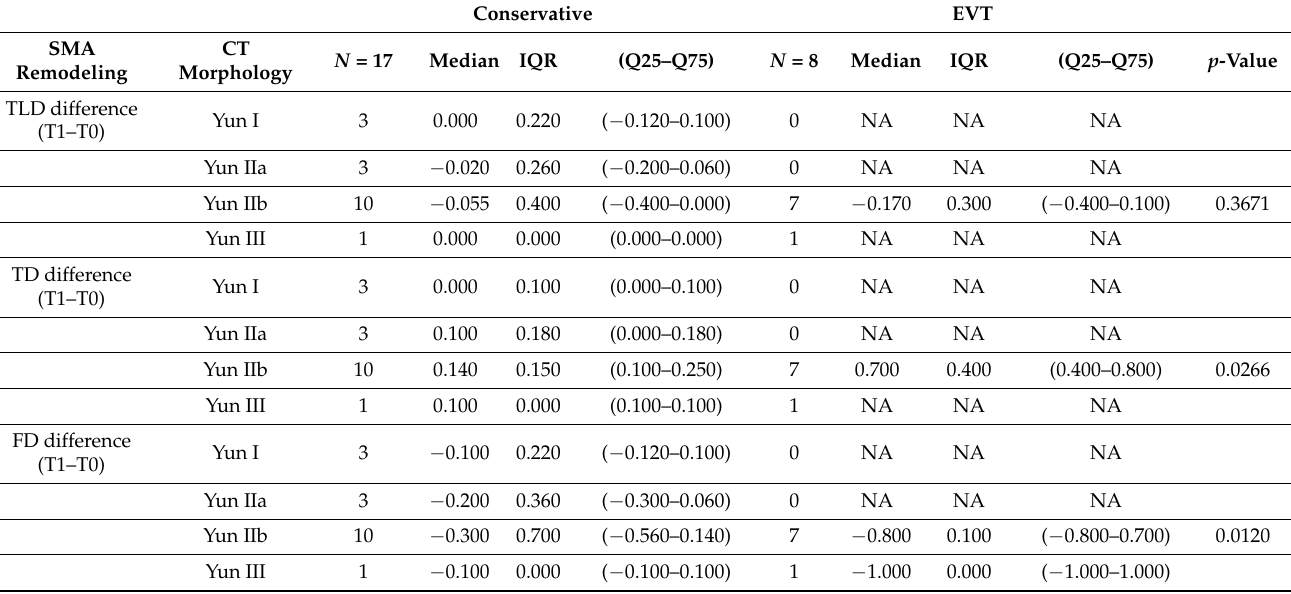
Table 3. SMA remodeling stratified by CT morphology and EVT. Conservative